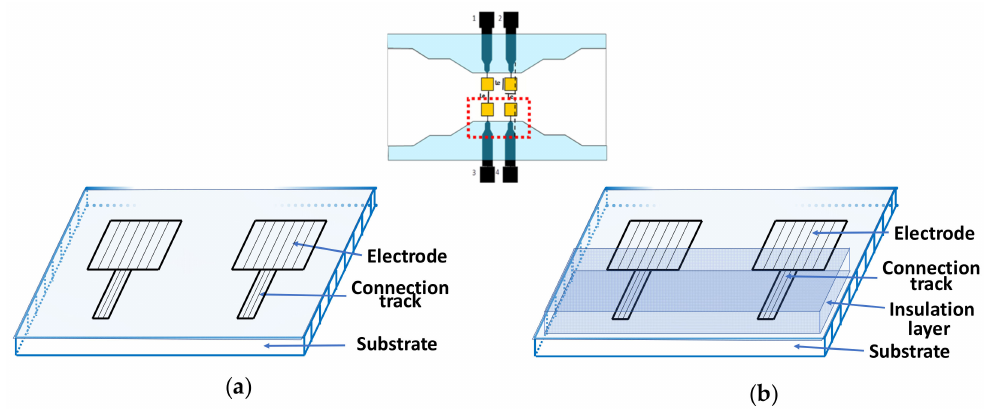
Figure 1. Electrode structures ( a ) without and ( b ) with an insulation layer on the electrode connection